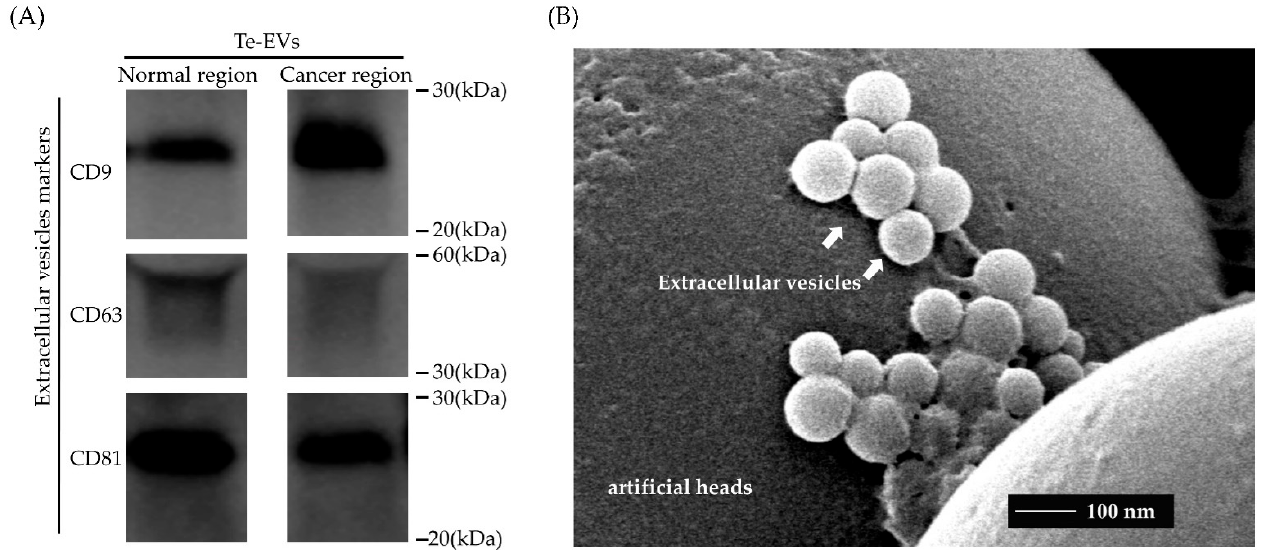
Figure 1. Confirmatory analysis of tissue-exudative extracellular vesicles (Te-EVs). EVs were isolated from serum-free cultures of tissue removed from the cancerous and normal ovaries of patients with ovarian clear cell carcinomas. ( A ) Western blot analysis showing EV-specific protein expression of CD9, CD 63, and CD81 in case 4. ( B ) A representative image of Te-EVs obtained from cancerous specimens in case 4 using transmission electron microscopy showing that the isolated clusters were mainly circular or oval membrane vesicles with a size of 30–100 nm, uniform in appearance, and exhibited the characteristic appearance of EVs.